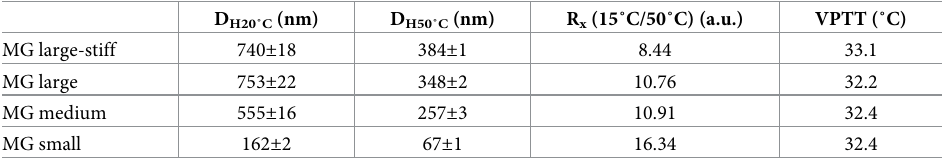
Table 1. Physical properties of